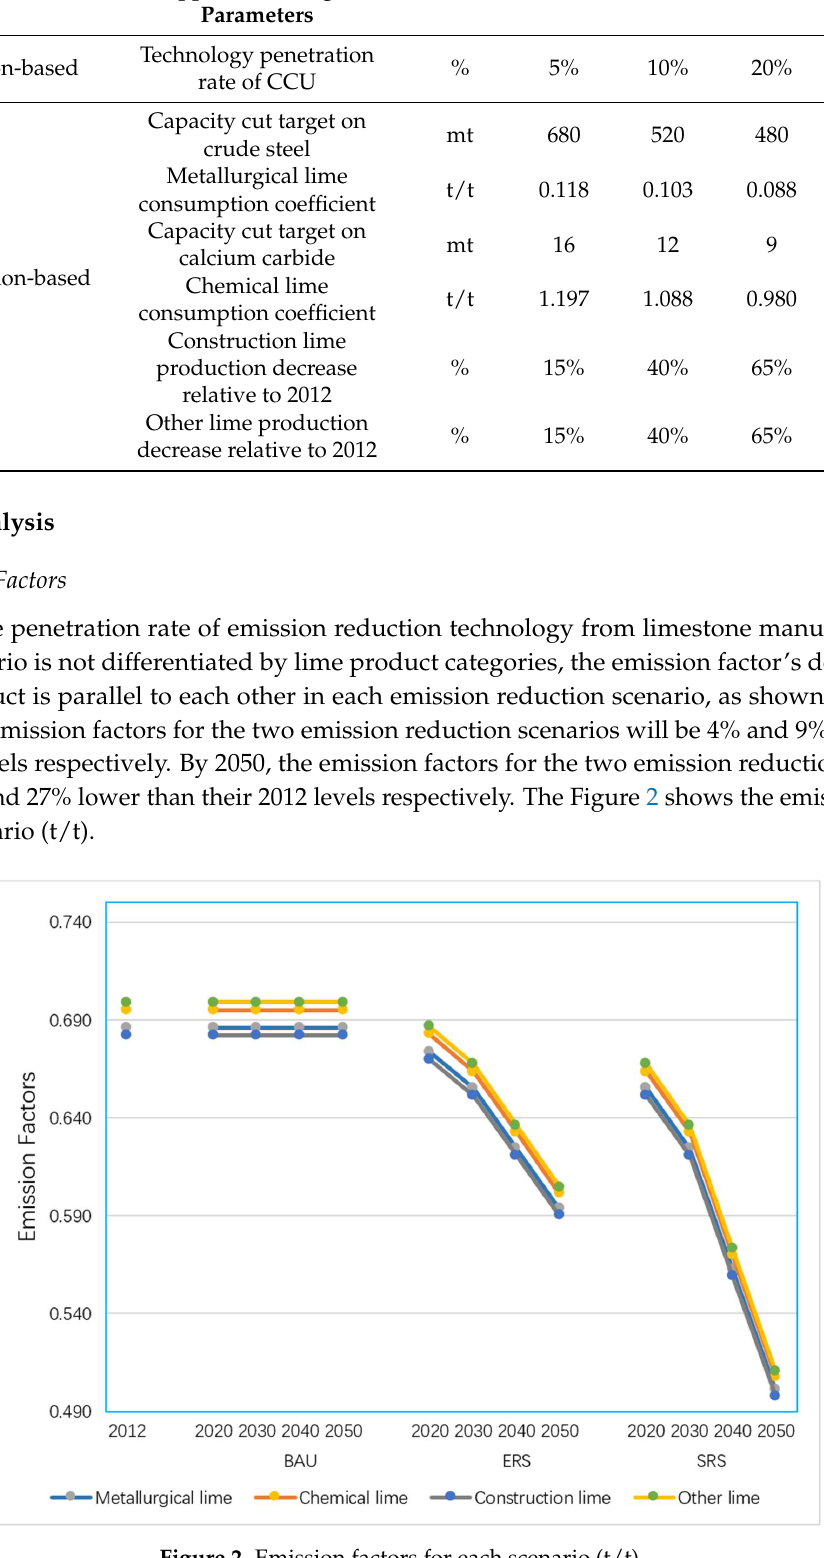
Figure 2. Emission factors for each scenario (t/t).